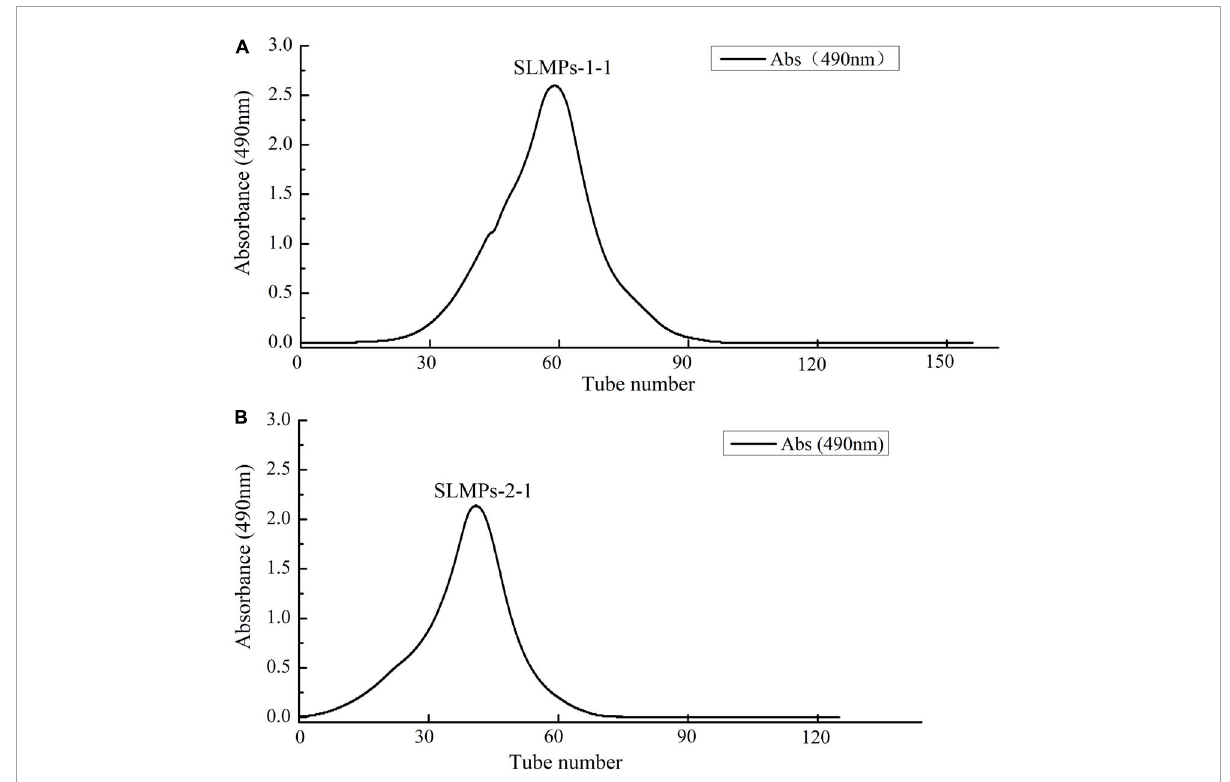
FIGURE2 Elution curve of SLMPs-1-1 (A) and SLMPs-2-1 (B) on Sephadex G-100 column to obtain SLMPs-1 and SLMPs-2.